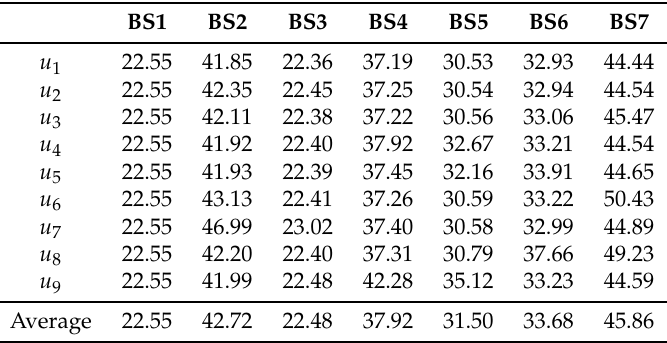
Table 2. SNIR of cluster heads in BS1.